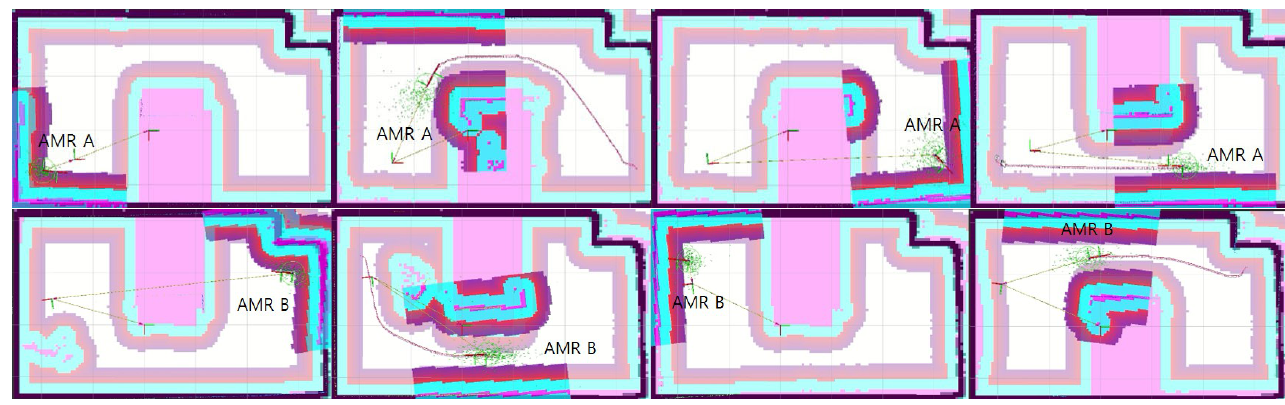
Figure 6. The cost maps of AMR A and B around three boxes under the lane